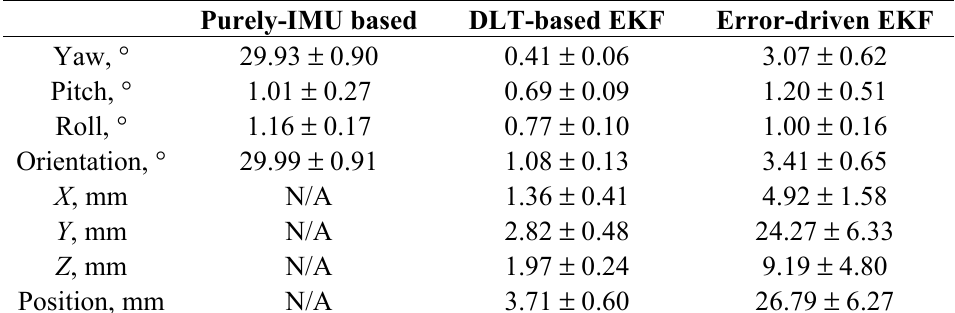
Table 5. Summary statistics of the performance metrics in the scenario (d).